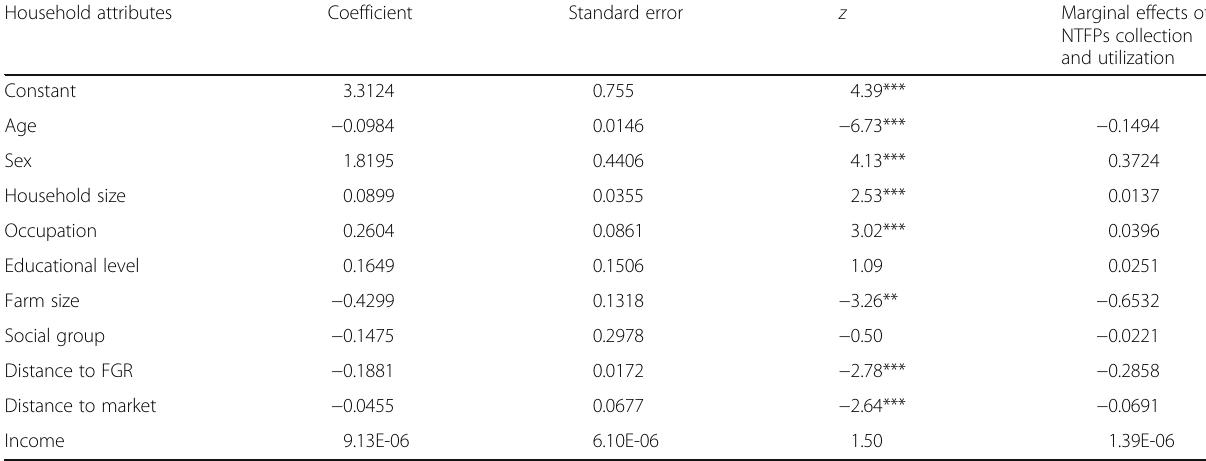
Table 4 Factors influencing household ’ s collection and utilization of non-timber forest products Household attributes Marginal effects of